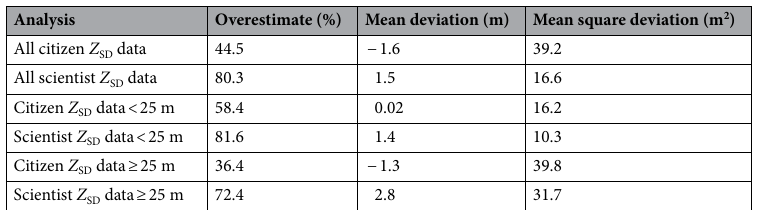
Table 1. Indirect comparison of citizen and scientist Z SD data with respect to under and overestimation and closeness. An underestimate of < 50% or a negative mean deviation means that in situ data underestimates satellite data and inversely. A percentage of overestimate or a mean deviation close to 0 means that there is no systematic under- or overestimation in the in situ data with respect to satellite data. When the mean square deviation is close to zero it means that in situ and satellite measurements are close together and exhibit a low